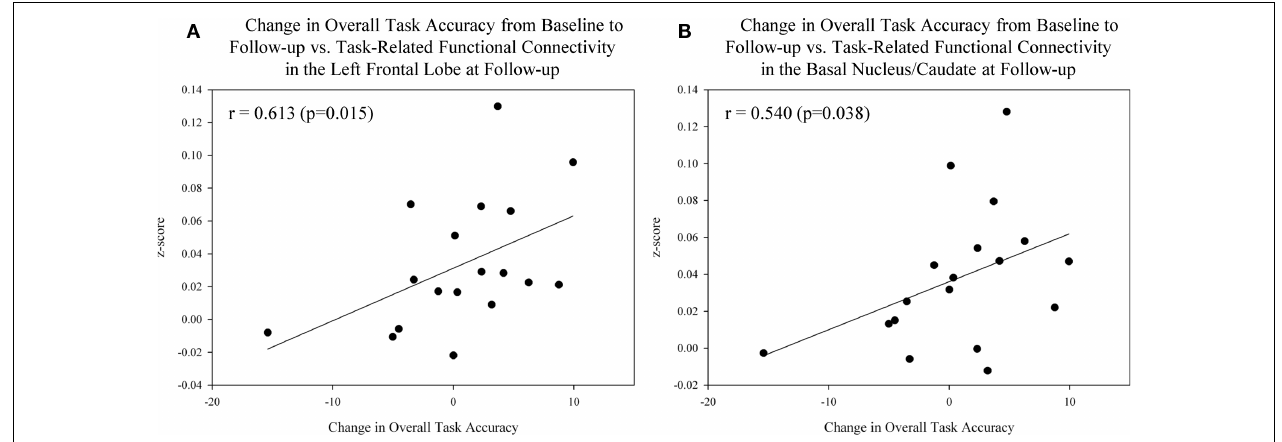
left basal nucleus/caudate [ (B) ; r = 0.540, p = 0.038] at the follow-up scan were observed in MCI participants ( n = 18). See Sections “Materials and Methods” and “Results” of the manuscript for further information. MCI = mild cognitive impairment, HC = healthy older adults, ROI = region of